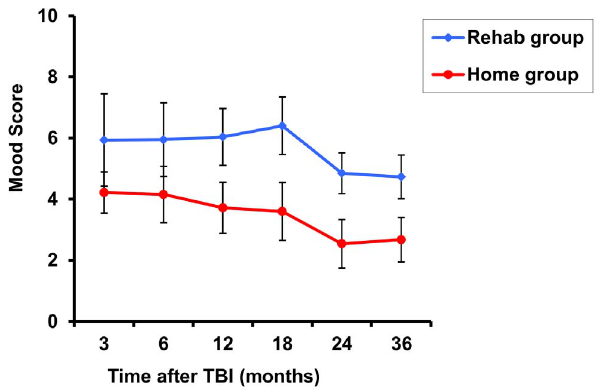
Figure 1. Estimated mean ( 6 1 SD) Wimbledon Self-Report Scale (WSRS) scores over time in the Rehab group (blue line; n=53) versus the Home group (red line;